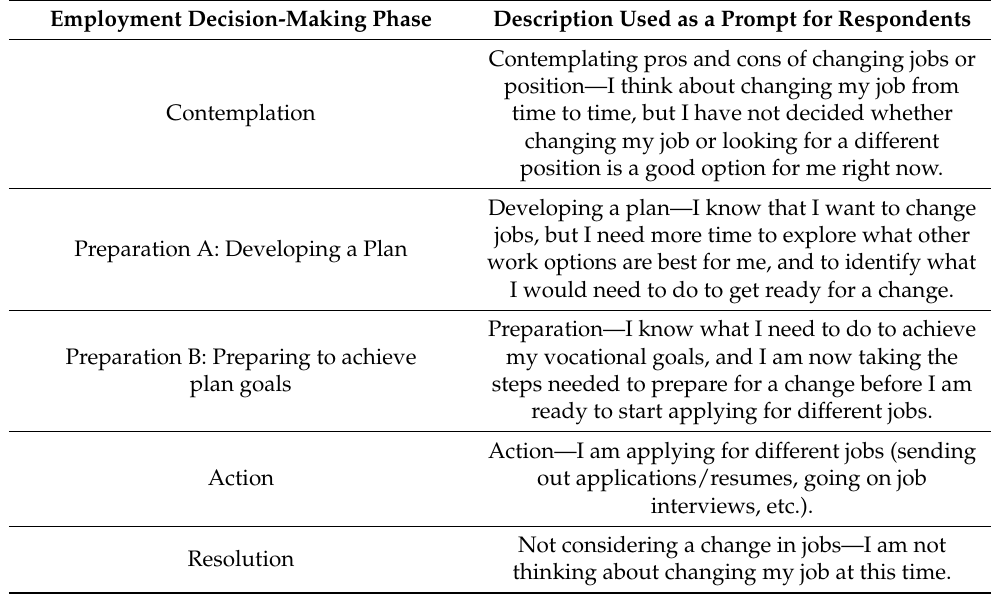
Table 1. Classification of Employment Status Scale